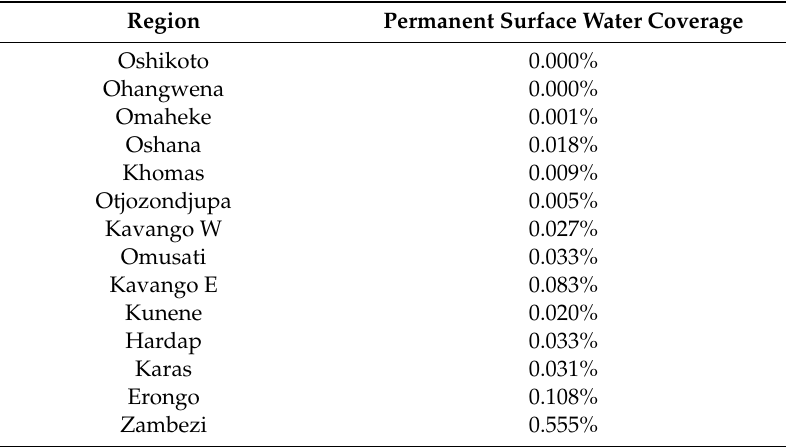
Figure 6. Regional Pattern and Trends in Permanent Surface Water. Table 5. Permanent Surface Water Coverage per Region.